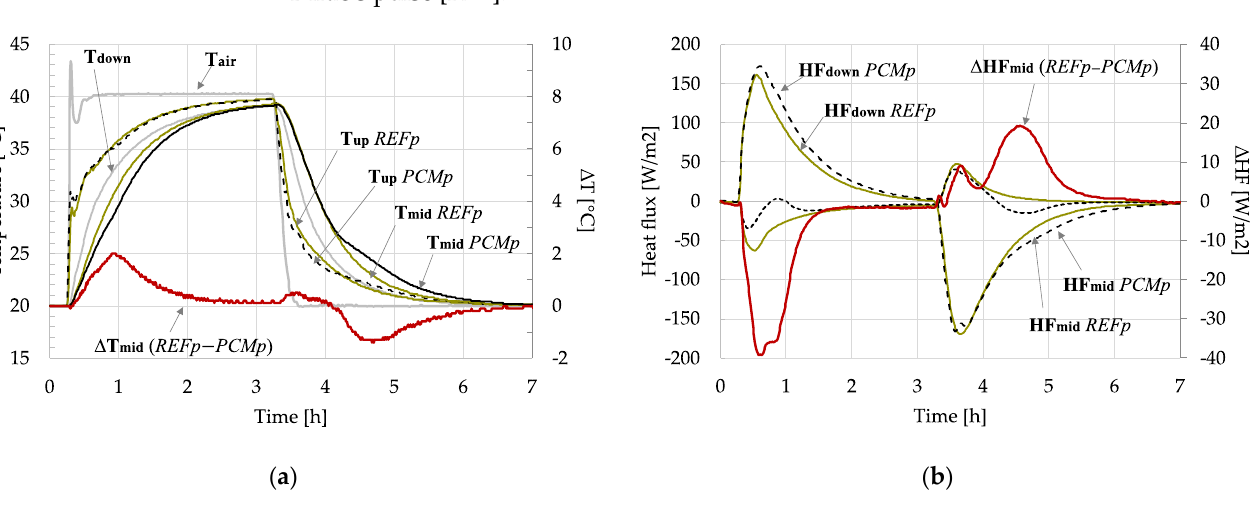
Figure 4. ( a ) Temperatures collected for both the reference and the PCM plaster samples. The curves of T air and T down were the same for both tests, therefore only one was depicted in the graph. Moreover, the red line is the difference between the values of T mid for the reference plaster and the PCM one, respectively. ( b ) Heat fluxes collected for both the reference and the PCM plaster samples. The red line is the difference between the values of HF mid for the reference plaster and the PCM one, respectively.